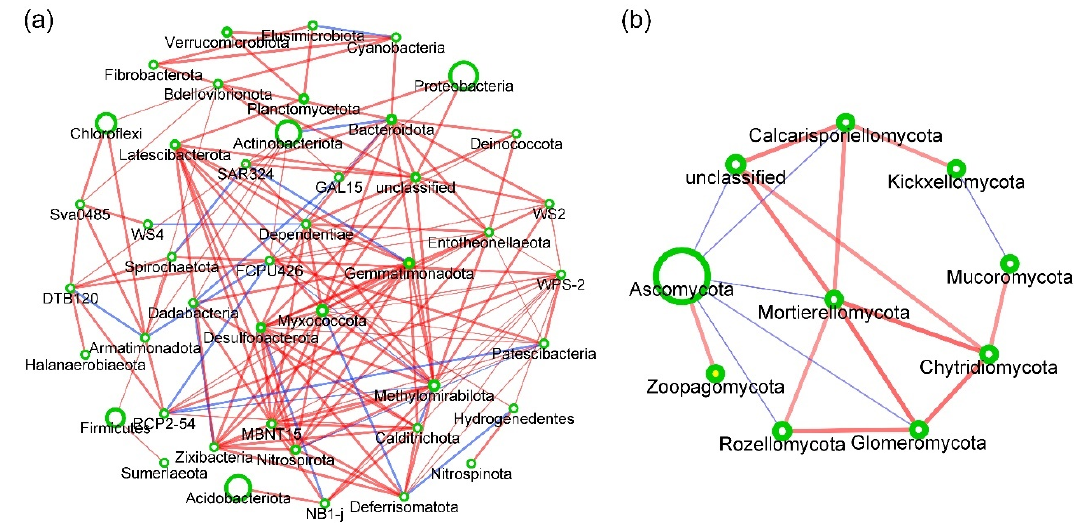
Figure 5. Network interaction diagram of dominant bacterial ( a ) and fungal ( b ) phyla. The line between the circles indicates that there is a correlation, red lines indicate a positive correlation, while the blue lines show a negative correlation. The size of the points represents the magnitude of phyla abundance, while the thickness of the line represents the correlation size. Each circle represents a microbial phylum. Red indicates a positive correlation, and blue indicates a negative correlation ( p < 0.05).